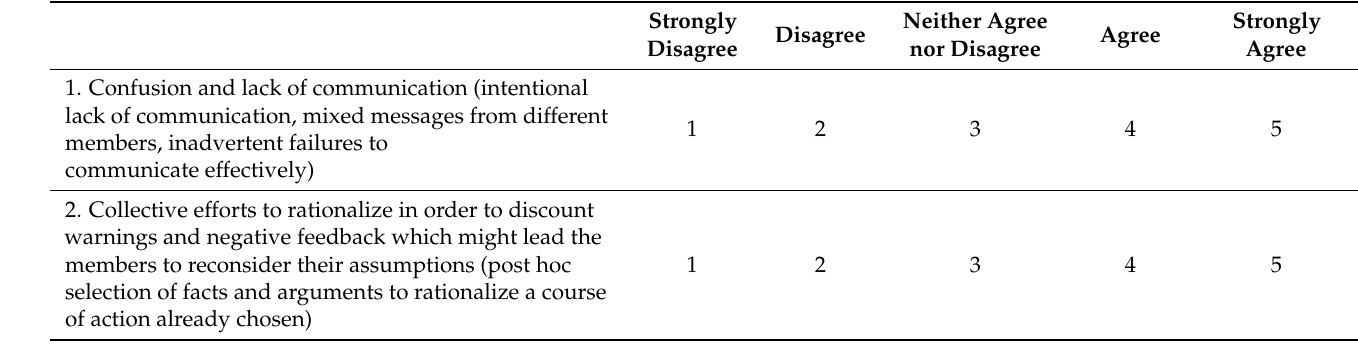
Table 1. Raters’ assessment tool for group dynamics in medical teams. Please indicate the level of agreement or disagreement with each of the following 14 statements, by circling the number best describing your opinion \ feeling regarding the team you just watched. The scale is from 1 (Strongly disagree) to 5 (Strongly